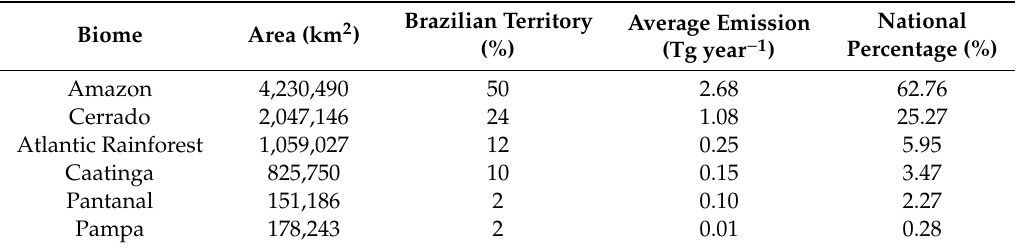
Figure 2. Annual total emission of PM 2.5 associated with fires in South America, Brazil, and in the Cerrado biome during the 2002–2017 period. Estimates were obtained using PREP-CHEM-SRC 1.8.3. Table 1. Annual average emission of PM 2.5 associated with fires in the Brazilian biomes for the 2002–2017 period. Estimates were obtained using PREP-CHEM-SRC 1.8.3.